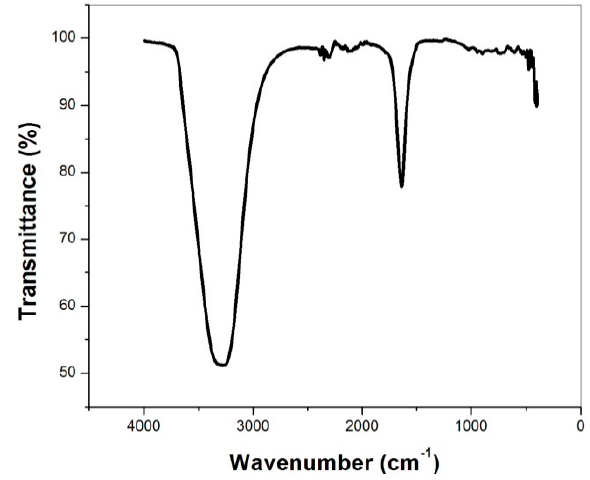
Figure 9. FTIR spectrum of mulberry leaves extract.